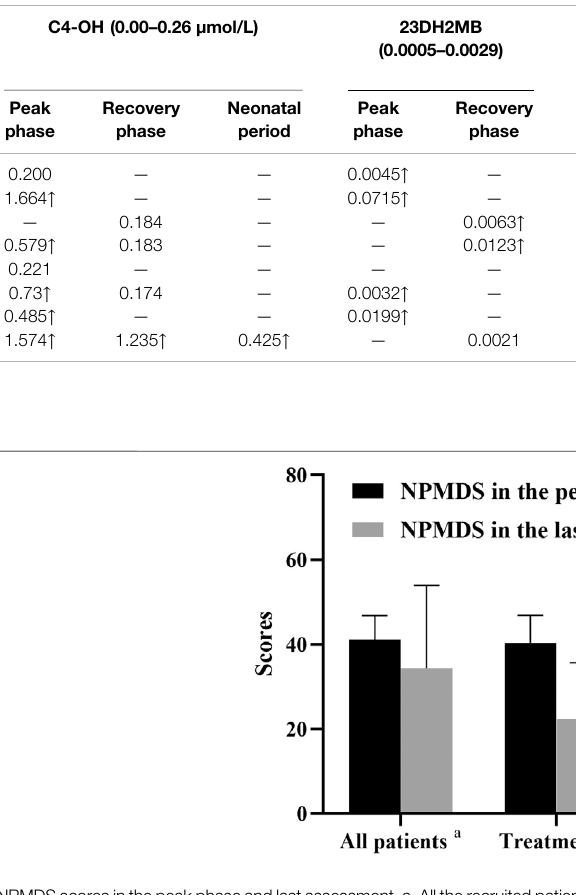
TABLE 2 | Metabolite results of extensive investigations of eight patients with HIBCH mutations.